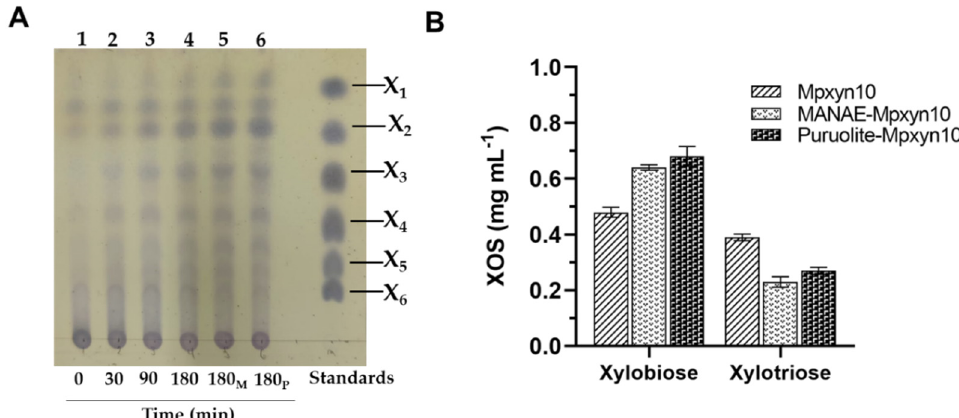
Figure 6. Production of XOS from soluble xylan of the EWC hydrothermal liquor. ( A ) Thin Layer chromatography (TLC) of the enzymatic hydrolysis products of EWC hydrothermal liquor. Lane 1: the beginning of the assay (control); lanes 2–4: free MpXyn10; lane 5: MANAE-MpXyn10; lane 6: Purolite-MpXyn10. ( B ) Quantification of XOS (xylobiose and xylotriose) produced after 180 min of the assay by HPLC.